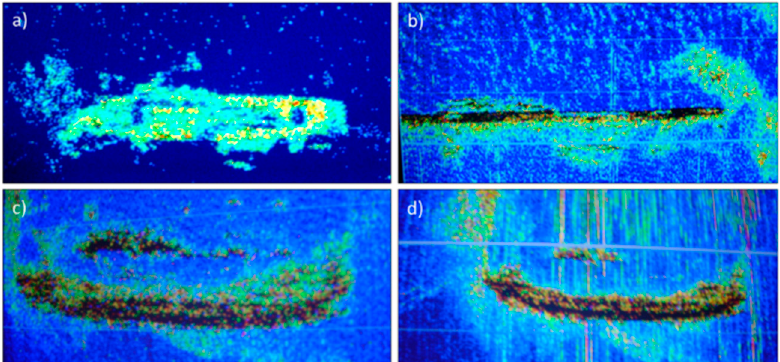
Figure 15. Sonograms acquired with analog low-frequency hull-mounted side-scan sonar Acson-100. (a-d) same object seen from different angles